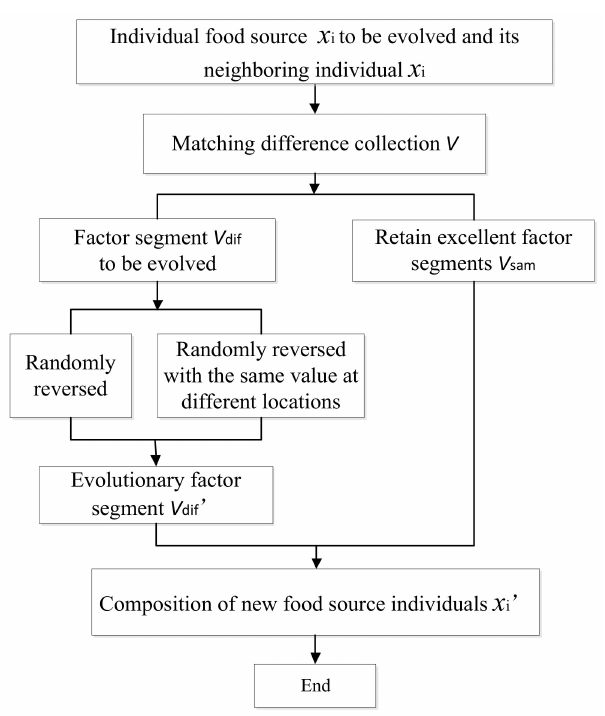
Figure 3. Food source evolution process based on